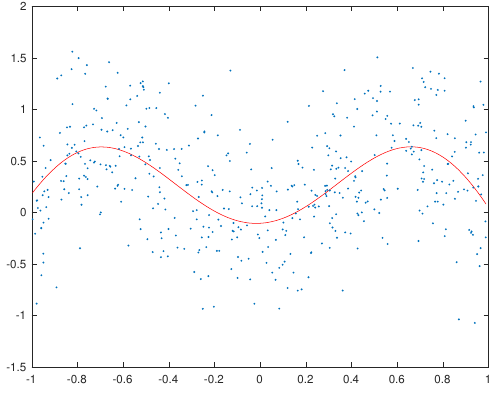
Figure 2. RPSGLA ( s = 5) with noisy data after 100 iterations.